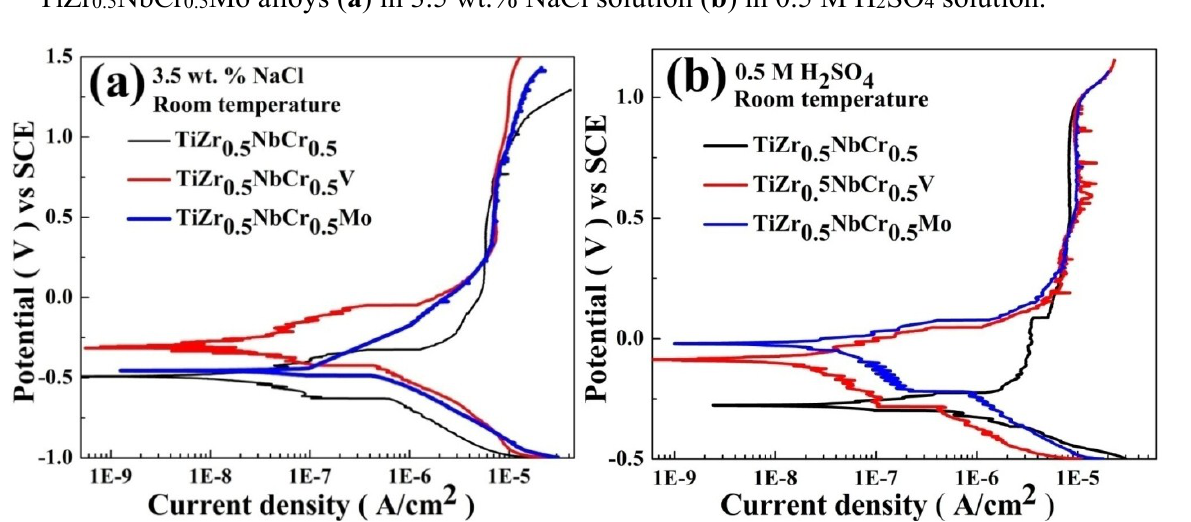
Figure 3. Potentiodynamic polarization curves of TiZr 0.5 NbCr 0.5 , TiZr 0.5 NbCr 0.5 V